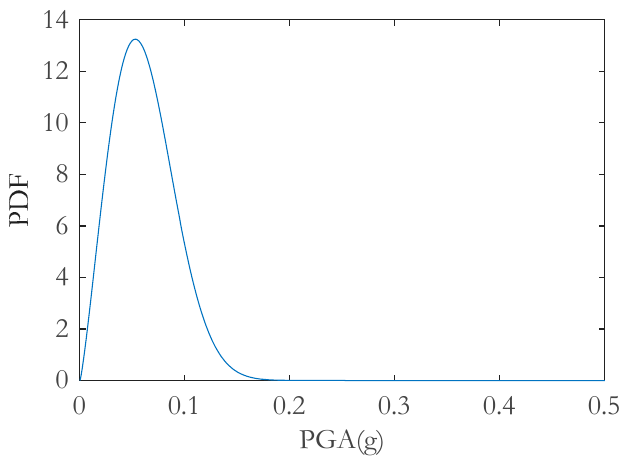
Figure 7. Probability distribution of earthquake.